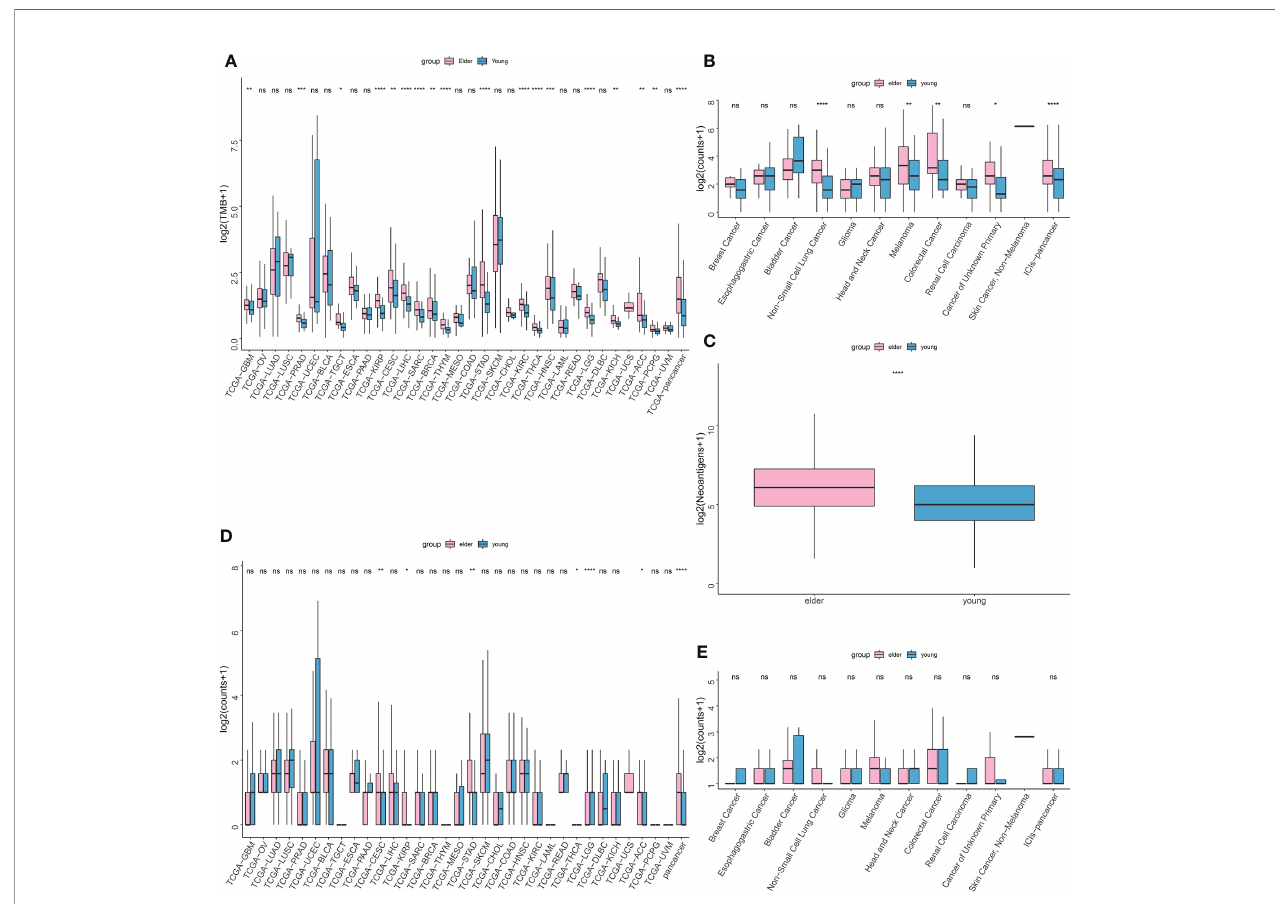
FIGURE 4 | (A) Difference in tumor mutation burden (TMB) between the older ( ≥ 50 years old) and younger groups in The Cancer Genome Atlas (TCGA) database. (B) Difference in tumor mutation burden (TMB) between the older ( ≥ 50 years old) and younger groups in the Memorial Sloan-Kettering Cancer Center (MSKCC) immunotherapy cohort. (C) Difference in neoantigen load (NAL) between the older ( ≥ 50 years old) and younger groups in The Cancer Genome Atlas (TCGA) database. (D) Difference in DDR pathway mutations between the older ( ≥ 50 years old) and younger groups in The Cancer Genome Atlas (TCGA) database. (E) Difference in DNA damage response and repair (DDR) pathway mutations between the older ( ≥ 50 years old) and younger groups in the Memorial Sloan-Kettering Cancer Center (MSKCC) immunotherapy cohort. ns, no signi fi cant difference *P < 0.05, **P < 0.01, ***P < 0.001, ****P <